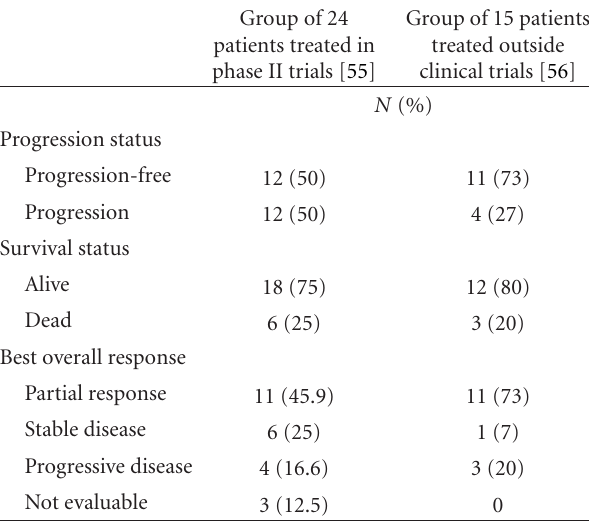
Table 1: The best overall responses, progression, and survival status in combined phase II clinical trials [55] and in group of patients treated outside clinical trials